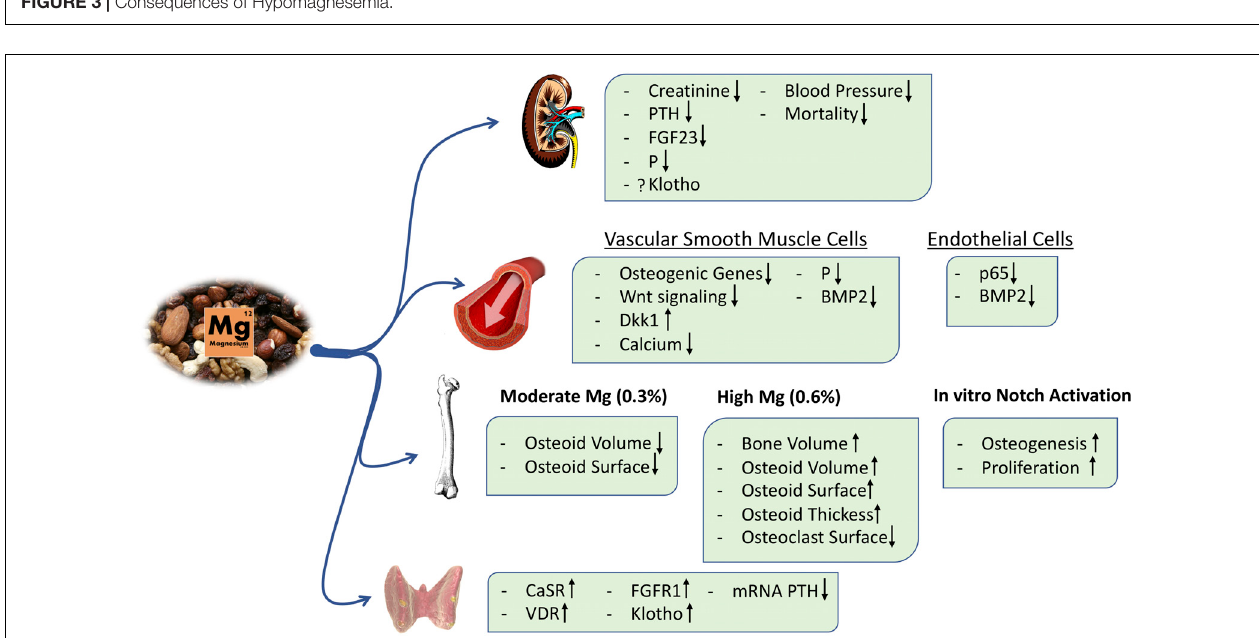
FIGURE 4 | Main effects of Mg